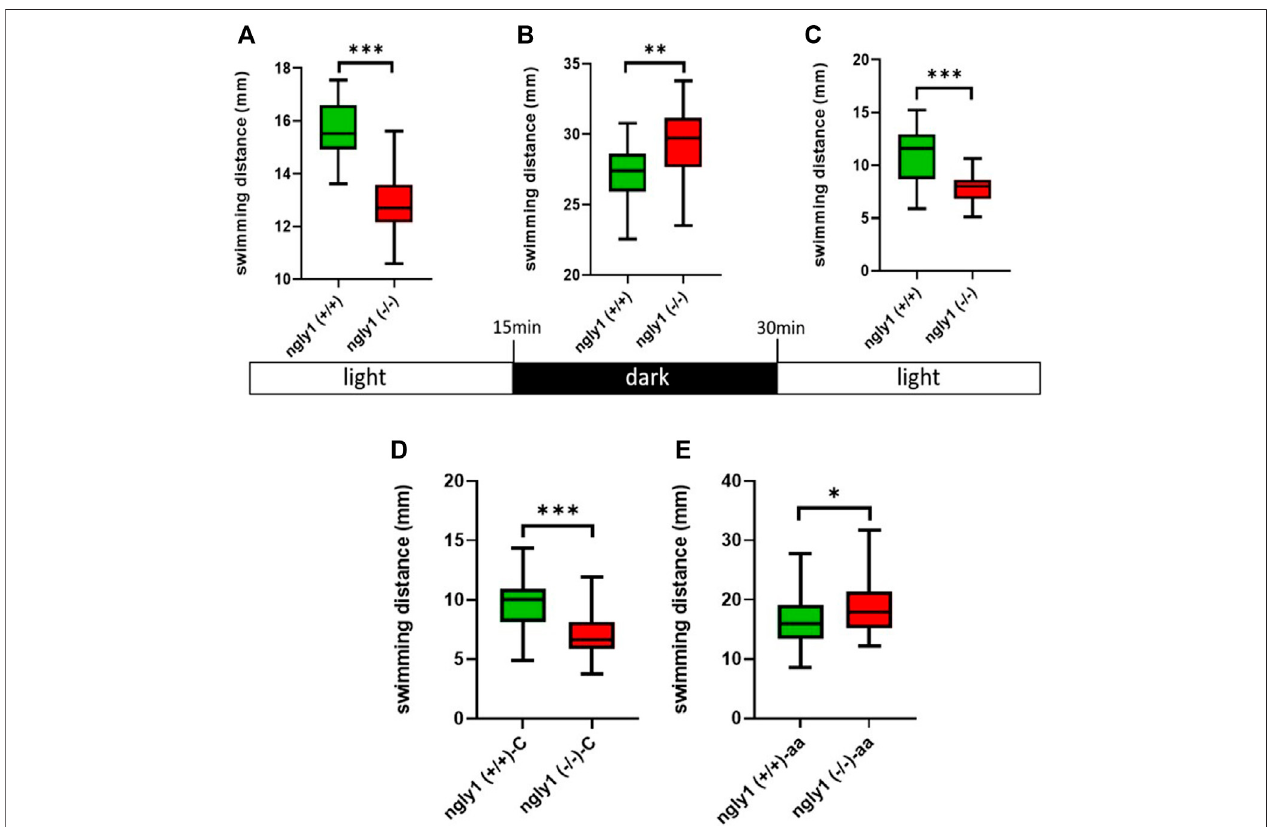
FIGURE 6 | Locomotion analysis. (A – C) Quanti fi cation of swimming distance of ngly1 ( +/+ ) and ngly1 ( − / − ) larvae for 5 min at various consecutive light conditions: light-dark-light. Each experiment was repeated 3 times, n = 91, t-test, ** p < 0.01, *** p < 0.001. (D) Quanti fi cation of swimming distance in larvae (6 dpf ) at normal conditions. C: control, t-test ( n = 12 in each group, *** p < 0.001). (E) Quanti fi cation of swimming distance after acetic acid (pH = 3.8) treatment- ngly1 ( +/+ ) compared to ngly1 ( − / − ) from one independent experiment. aa: acetic acid, t-test ( n = 36 in each group, * p < 0.05).